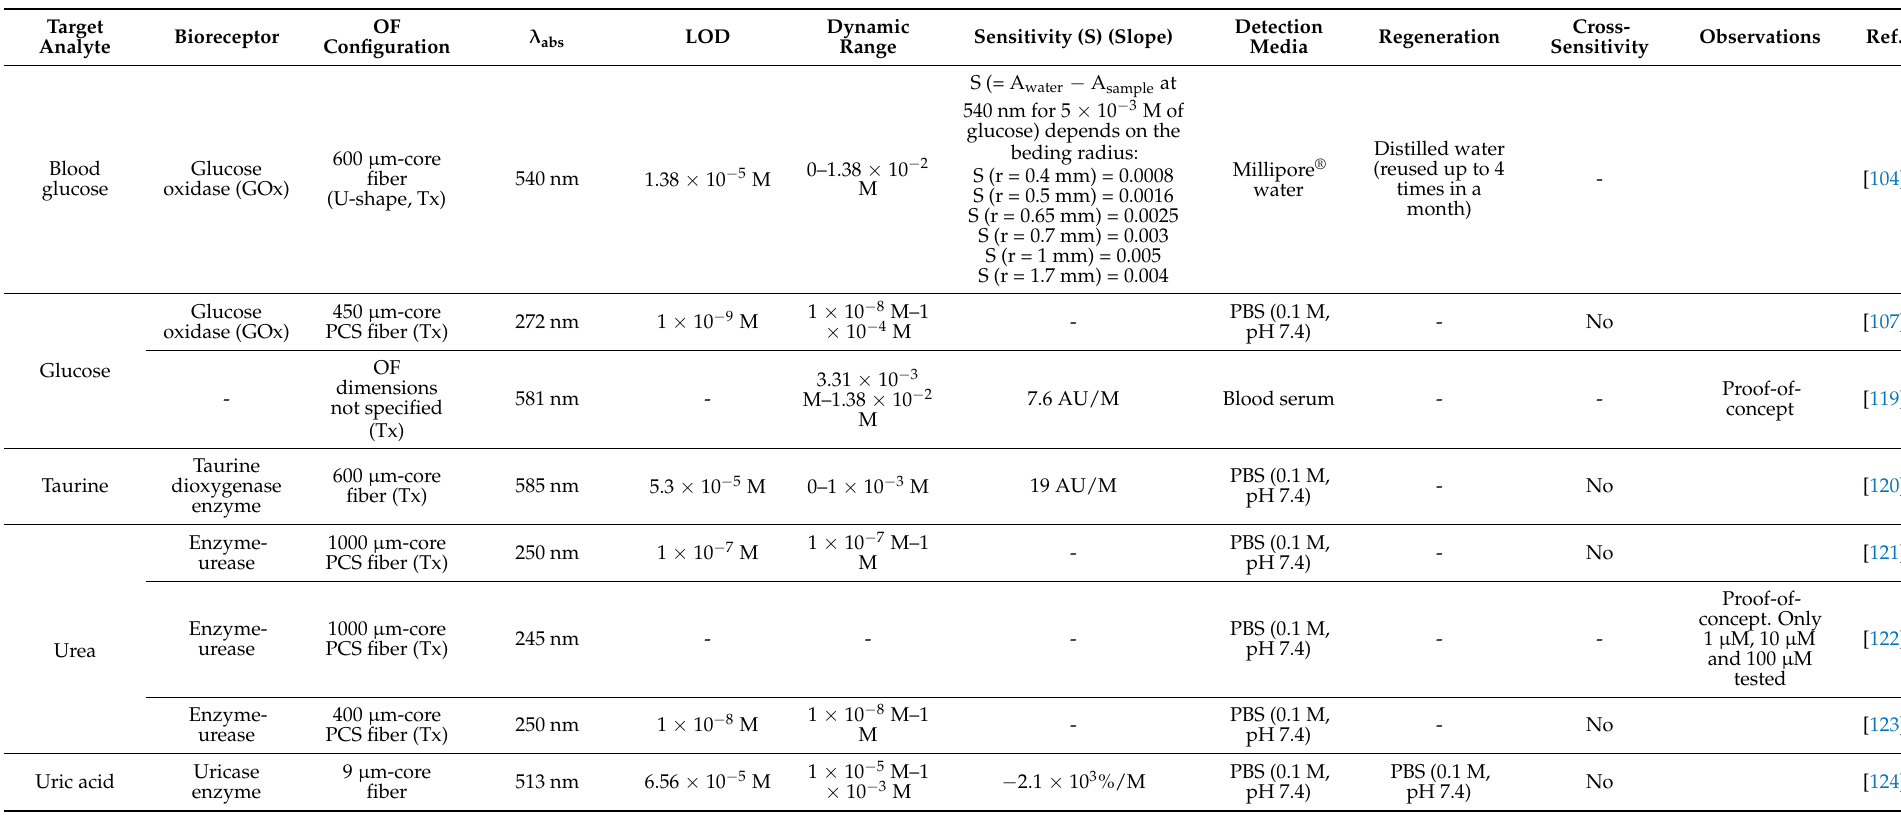
Table 7. Optical fiber biosensors based on absorption using enzymes as bioreceptors. The dash indicates that information about that parameter is not available in the original manuscript. Target